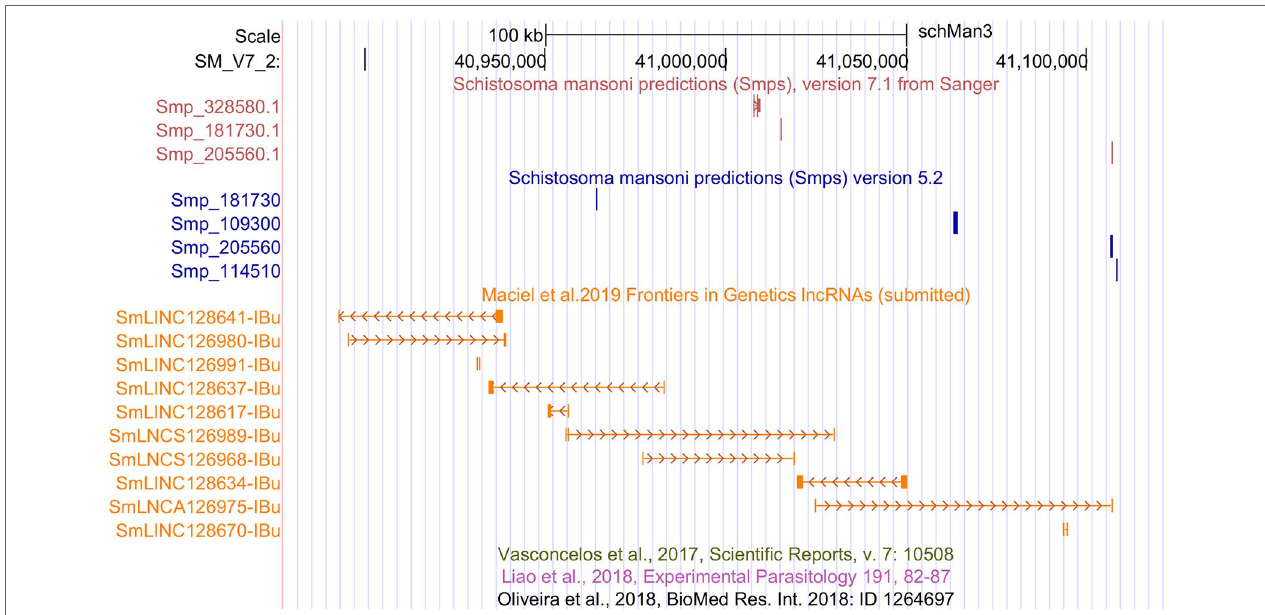
FIGURE 1 | Novel S. mansoni lncRNAs discovered in a protein-coding desert locus . Snapshot of a S. mansoni genome browser image, showing a region spanning 245 kb on chromosome 2 with coordinates SM_V7_2:40,877,676-41,122,371 (top black row). The red track (top) shows the three protein-coding genes from transcriptome version 7.1, whereas the blue track (middle) represents the protein-coding genes from version 5.2. The orange track (lower track) shows seven intergenic lncRNAs (SmLINCnnnnnn-IBu), two sense lncRNAs (SmLNCSnnnnnn-IBu), and one antisense lncRNA (SmLNCAnnnnnn-IBu) that were not annotated by the previously published works on lncRNAs, of which there are three empty tracks at the bottom, namely, Vasconcelos et al. (2017), Liao et al. (2018), and Oliveira et al.